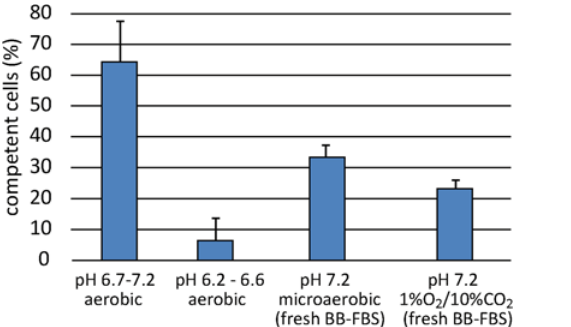
Fig 6. Neutral pH opens the opportunity for competence development triggered by oxidative stress. H . pylori N6 was grown microaerobically in BB-FBS overnight until growth phase before competence development (OD 600 ~0.2). Cells were exposed to different pH and atmospheric conditions for 1 hour. Data stem from at least three experiments; error bars, standard